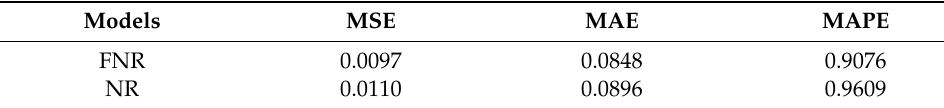
Figure 6. The curves of the true value, FNR model and NR model. Table 4. The results of forecasting errors for different